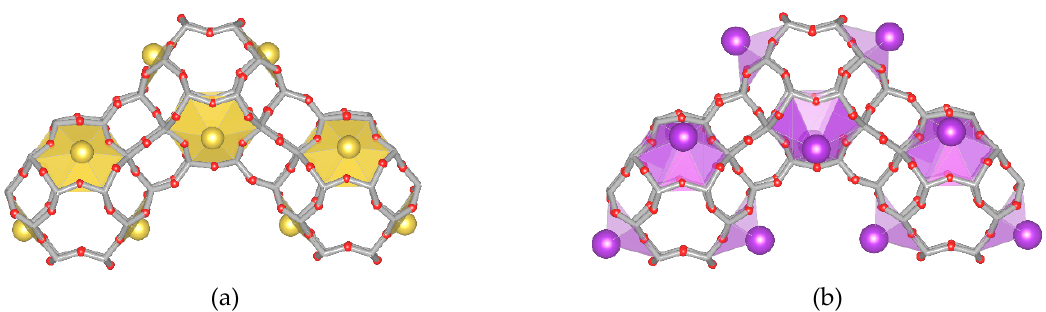
Figure 4. Fragment of the FAU structure with the M 32 Si 160 Al 32 O 384 formula (model “B”), where M + : ( a ) Na + in the SII sites and ( b ) K + in the SII sites.